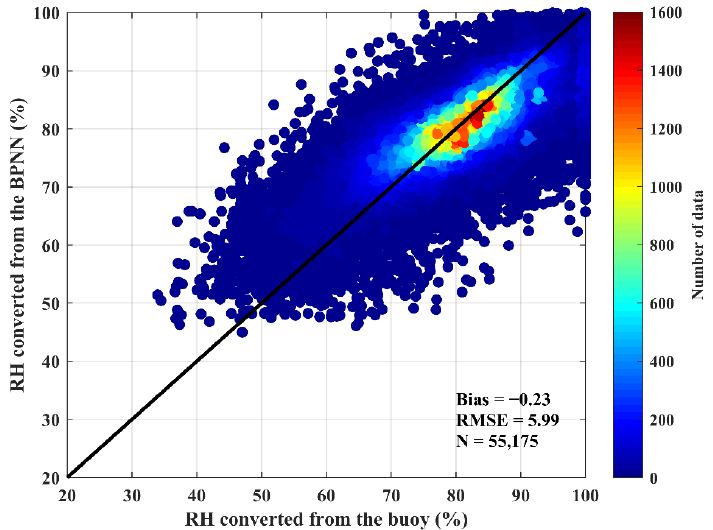
Figure 4. Comparison of the estimated relative humidity (RH) from the BPNN retrieval and the buoy and ECMWF ERA5 data over the global oceans, for 55,175 data points from 2012 to 2020. The colored bars represent the number of data points in the specific bin. The bin size is 2 × 2%. Each colored point is located at the center of the